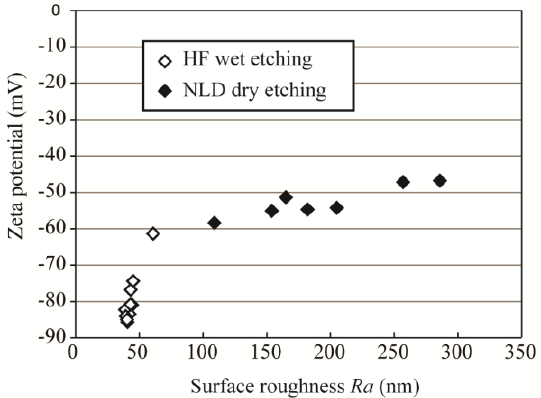
Figure 6. Effective zeta potential as a function of surface